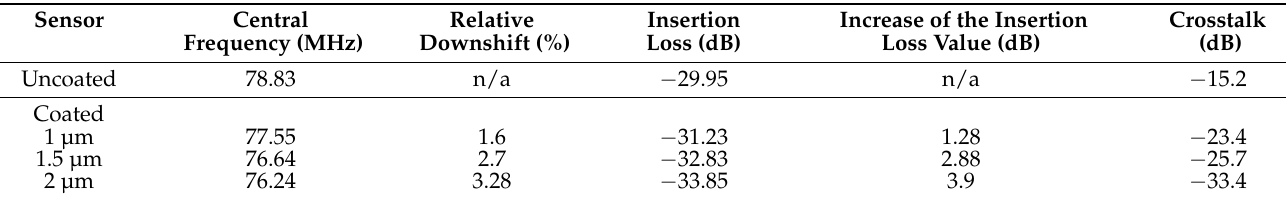
Figure 3. C p (right axis and circle markers) and R p (left axis and square markers) equivalent circuit parameters measurement with an impedance meter HP 4195A. Table 1. Electrical measurements of insertion loss and central